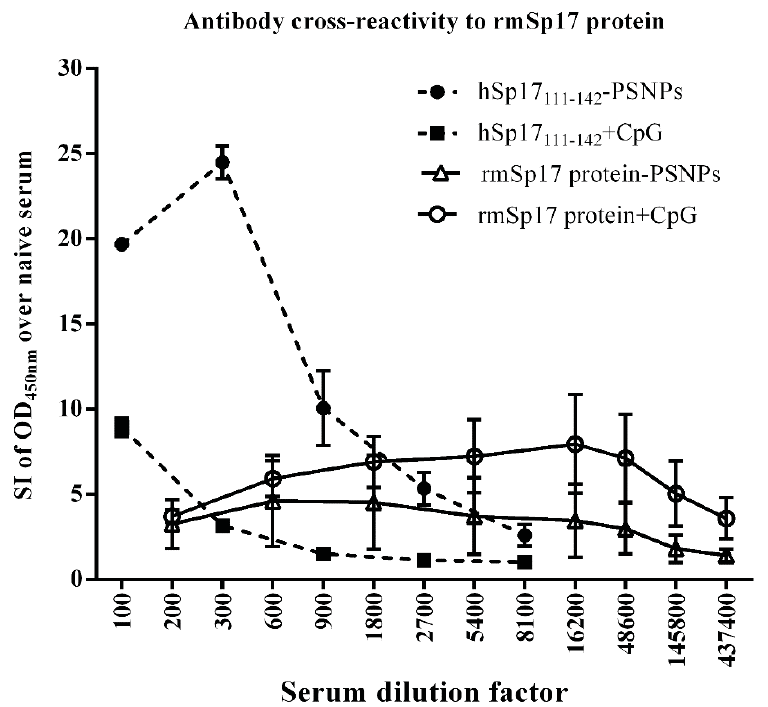
Figure 4. Antibody cross-reactivity to rmSp17. Serum from C57BL/6 mice ( n = 3/group) immunised with hSp17 111–142 (100 (cid:3)g/dosage) and rmSp17 protein (100 (cid:3)g/dosage) both adjuvated with either CpG (25 (cid:3)g/dosage) or PSNPs (1% solid/dosage) were assayed in ELISA coated with rmSp17 protein (5 (cid:3)g/mL) to test the cross-reactivity of these sera to the rmSp17 protein. Standard 2 immunisations intradermally at the base of tail. Data presented as average SI of OD 450 nm over naive ±